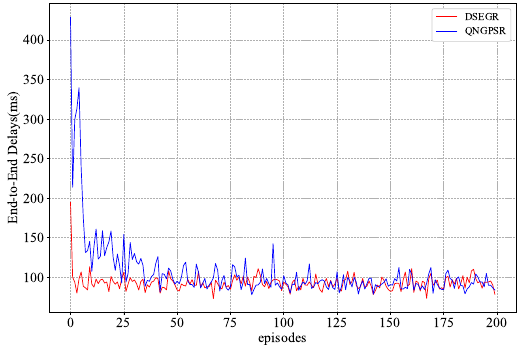
Figure 4. Convergence performance comparison of average E2E delay between QNGPSR and DSEGR in the training